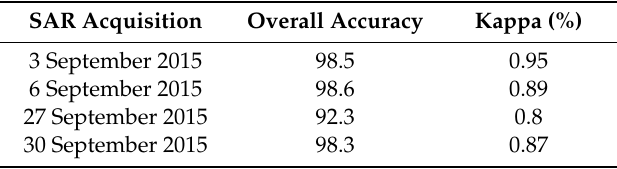
Table 4. Confusion matrix results of near-coincident SAR intensity (dB) threshold-derived surface water masks compared to a single clear sky optical SPOT scene from 17 September 2015. Note: results do not represent absolute accuracies, as the optical water masks contain some uncertainty and the comparison results represent acquisitions from different days.